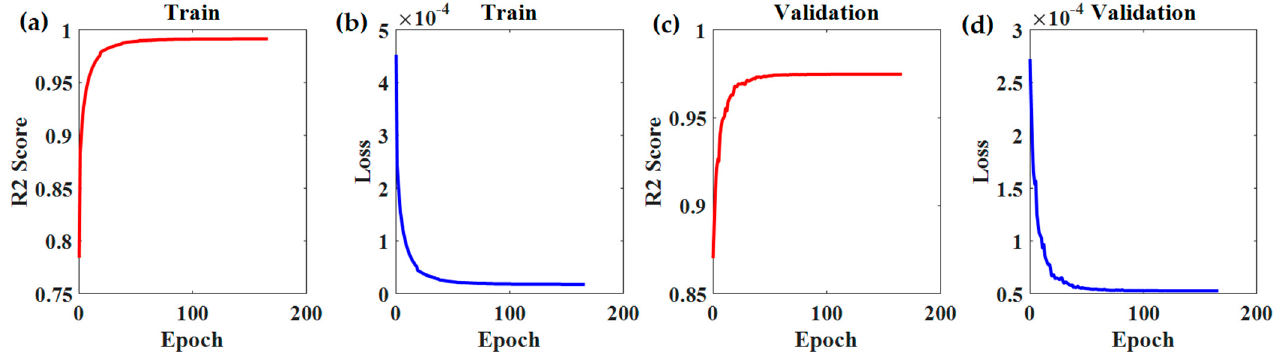
Figure 3. Training process of GPRSW. ( a ) The R 2 value during training; ( b ) the RMS loss during training; ( c ) the R 2 value of validation data sets; ( d ) the concurrent RMS loss of validation datasets during training.